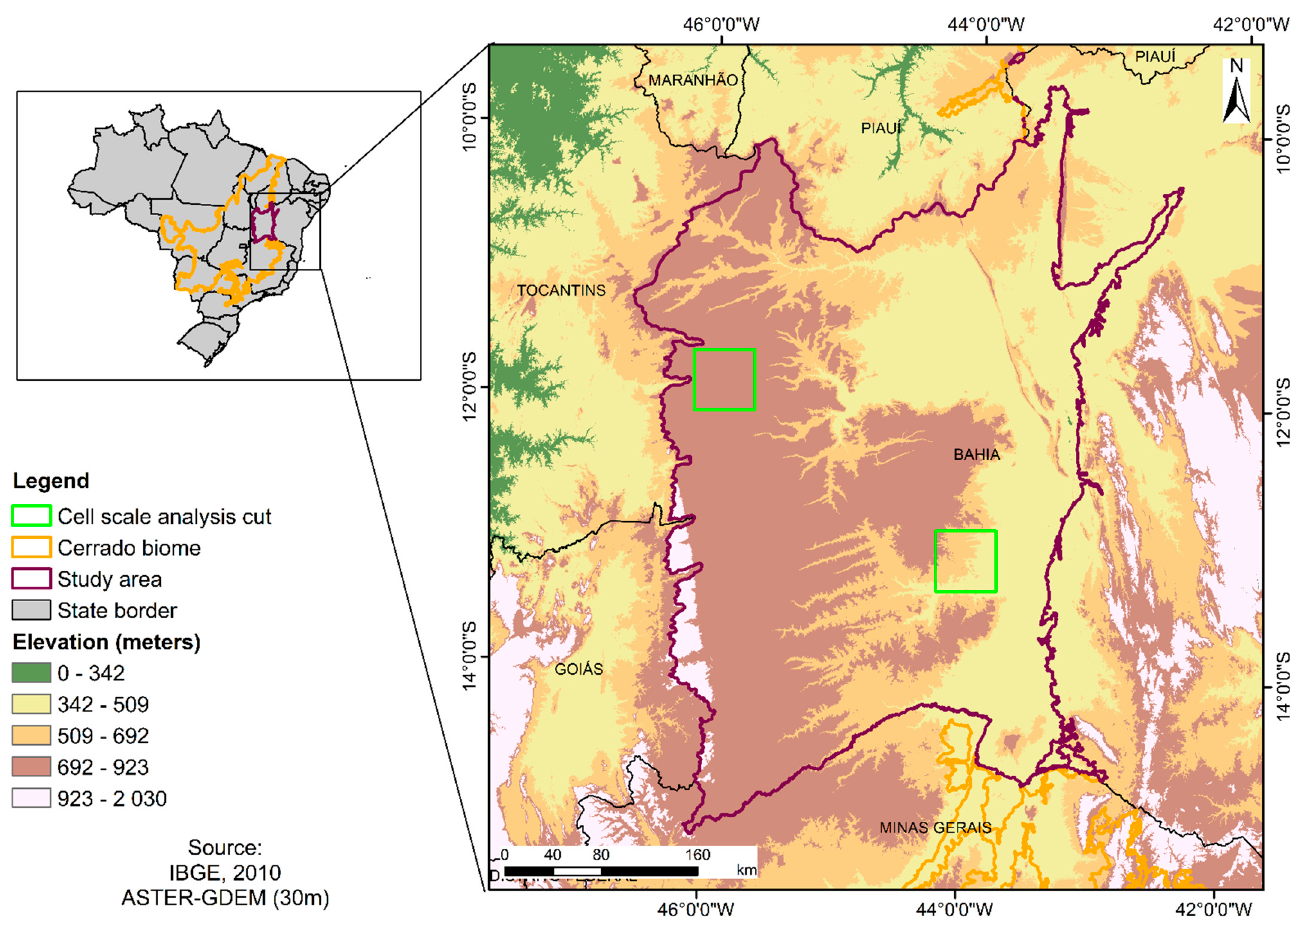
Figure 1. Study area–Cerrado biome in the state of Bahia, Northeastern Brazil with altimetry.